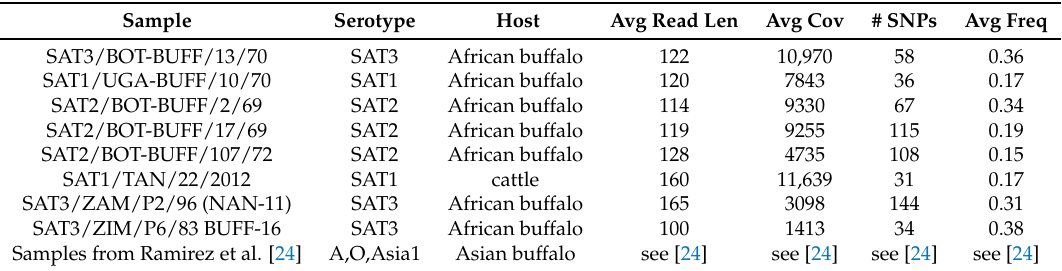
Table 1. Average length for mapped reads (Avg Read Len), average coverage (Avg Cov), number of selected SNPs, and their average minor allele frequency (Avg Freq) for each sample. SAT: South African